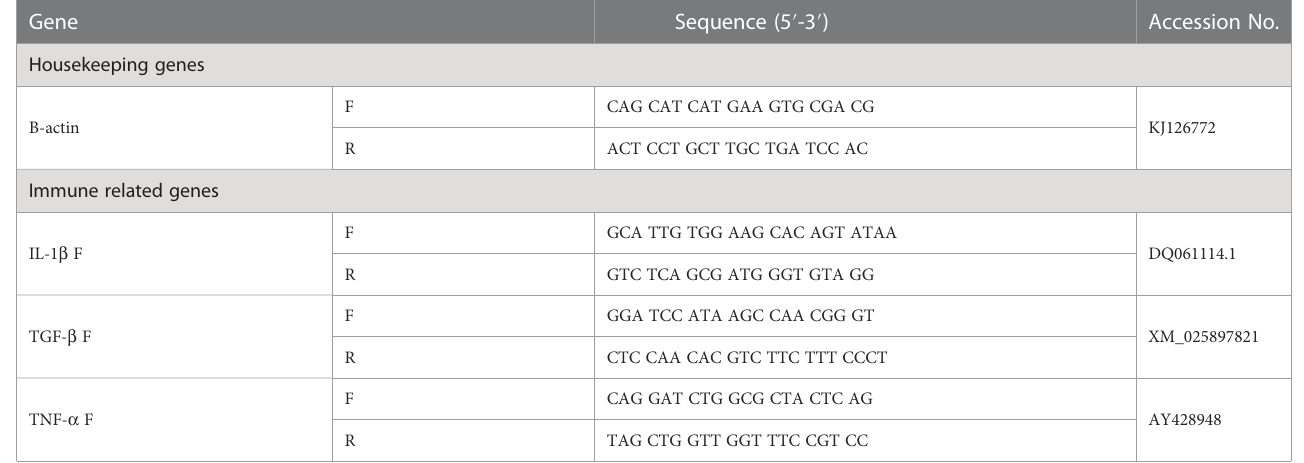
TABLE 1 The used gene primers. Gene Sequence (5 ′ -3 ′